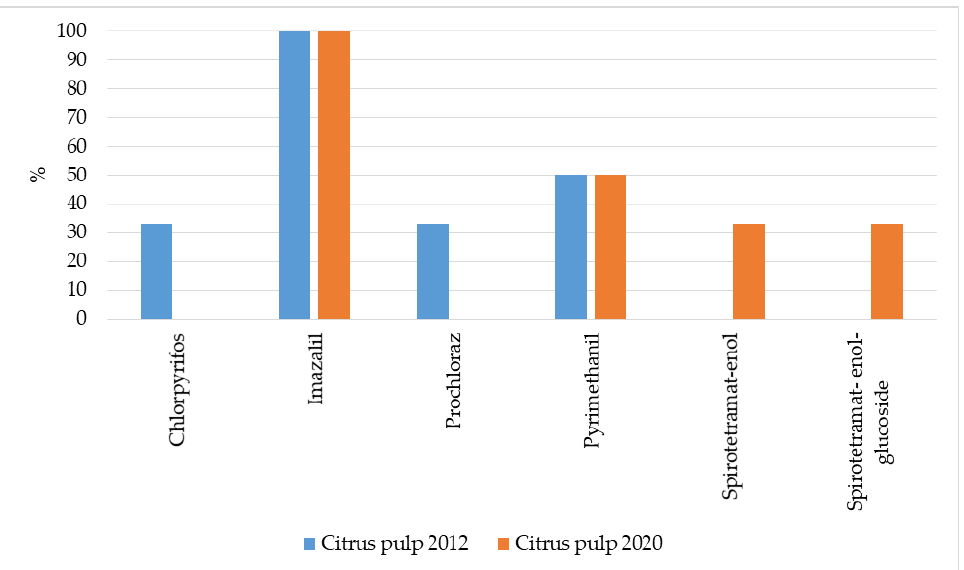
Figure 6. Frequency of occurrence of pesticides in the analysed samples of citrus flesh in 2012 and 2020, expressed as percentage share.